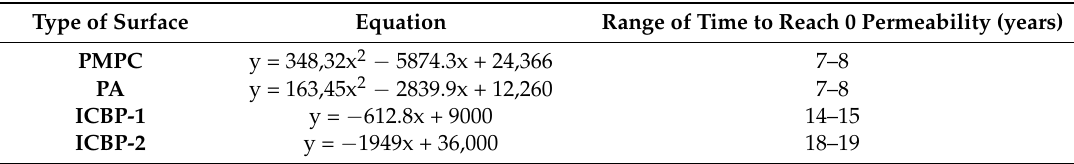
Table 6. Trends for the loss of permeability on each PPS